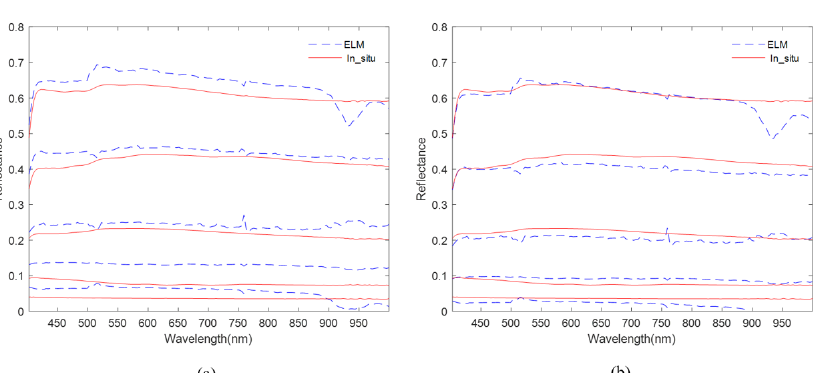
Figure 10. Comparison of the reflectance results of multi-gray level target retrieved by ELM method with in suit measurement results: ( a ) ELM method; and ( b ) ELM method of adding illumination correction.